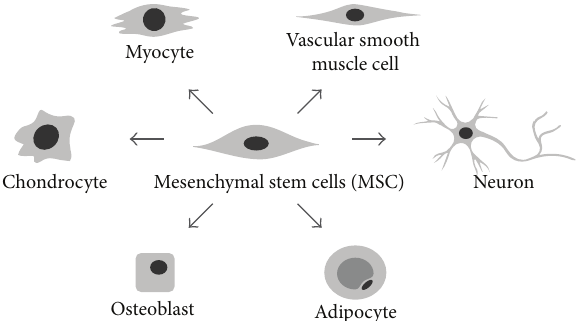
Figure1:Multilineagedifferentiationofmesenchymalstem/stromal cells (MSC). Multipotent mesenchymal stem cells (MSC) have been derived from numerous vascularized tissue sources, including bone marrow, adipose, and skeletal muscle tissue, among others. Multilineage differentiation includes osteoblastic, chondrogenic, myogenic, smooth muscle, and neurogenic differentiation. With progressive differentiation toward a mature cell phenotype, often the capacity for differentiation down a competing lineage is lost.